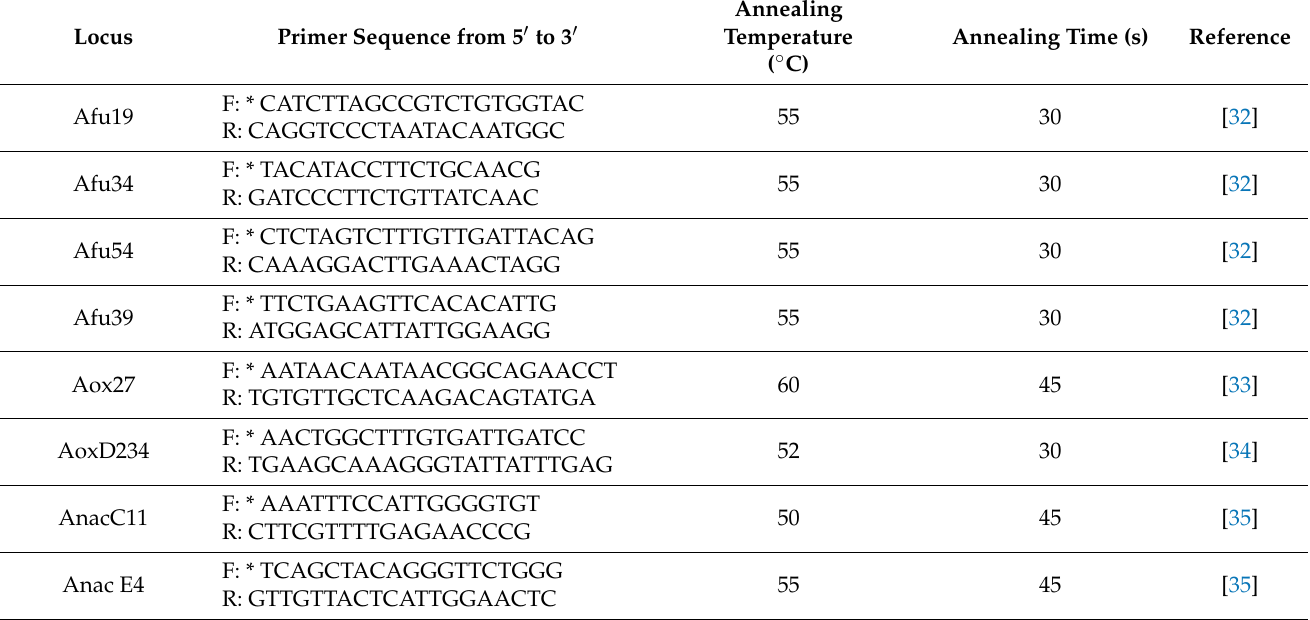
Table 2. Microsatellites analyzed in the